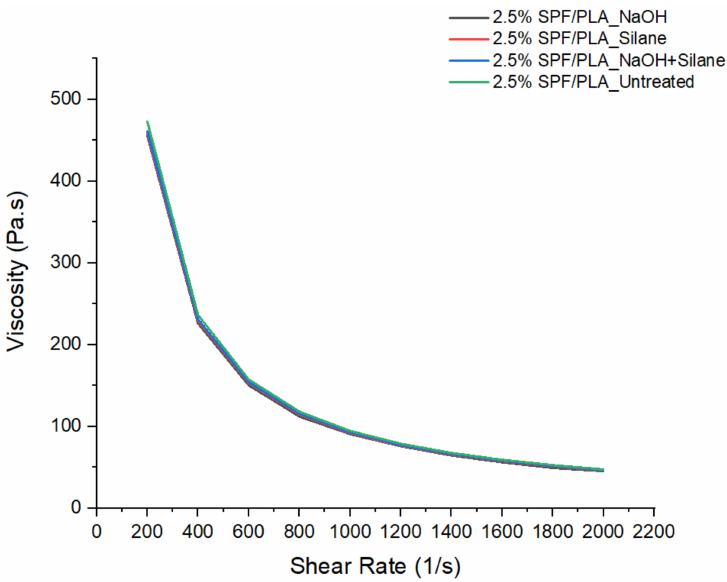
Figure 8. Results of viscosity vs. shear